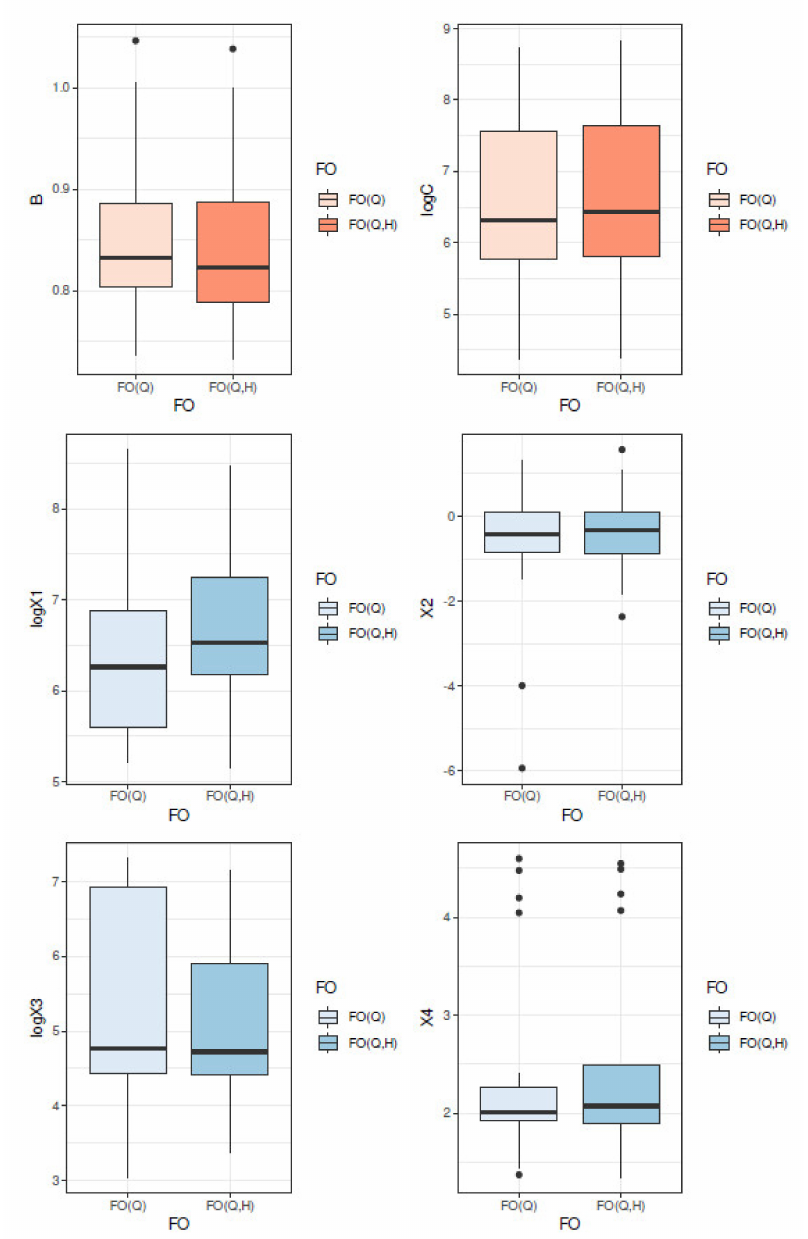
Figure 8. Distribution of the comparison of GRLoieau2J parameters B and C and X1, X2, X3 and X4 of the GR4J model for the two objective functions FO (Q) and FO (Q, H) and for the two calibration